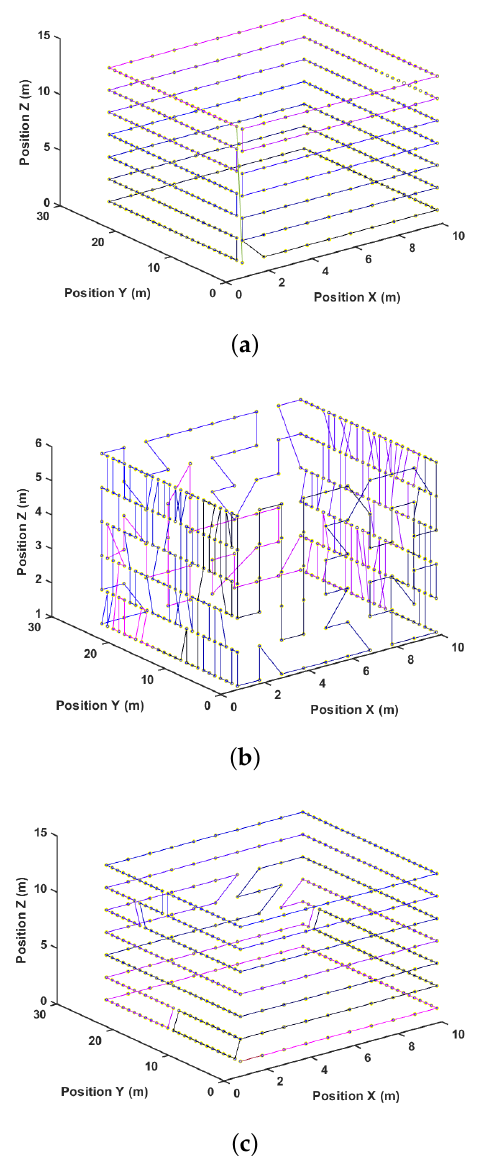
Figure 13. Path after solution for pr. ( a ) Greedy. ( b ) Genetic algorithm (GA). ( c ) Three-dimensional dynamic for Coverage Path Planning